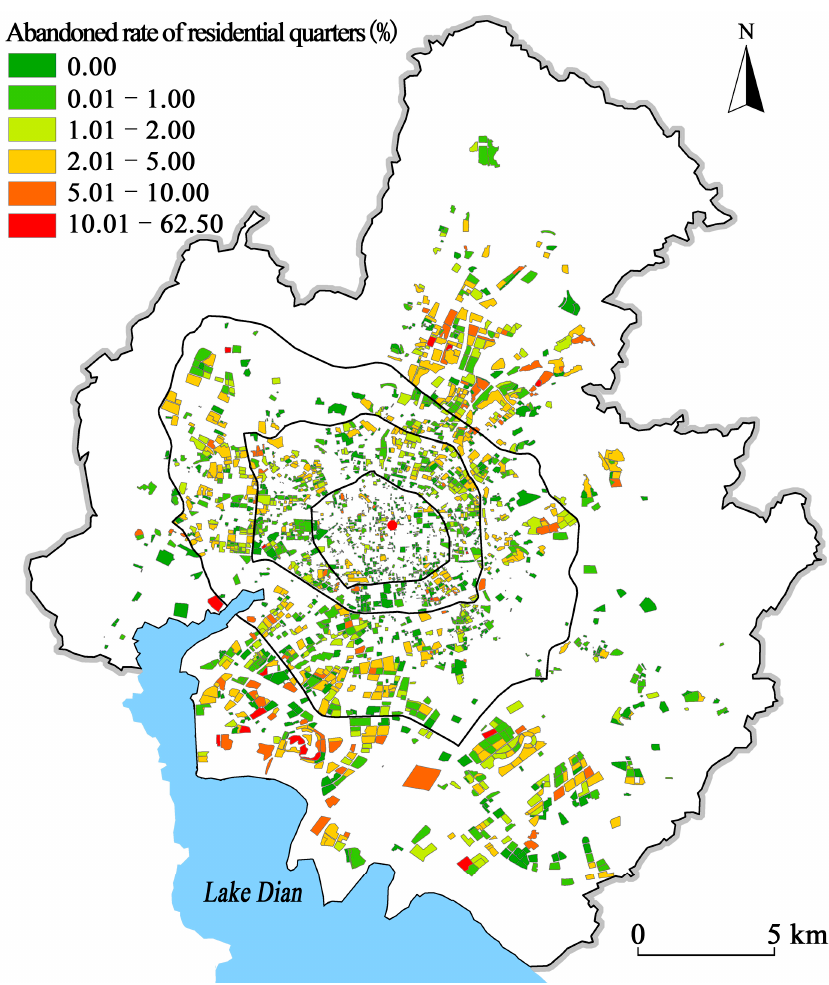
Figure 4. Spatial pattern of abandonment degree in Kunming’s Main Urban District.